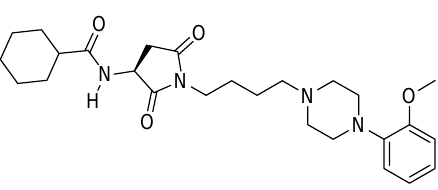
Figure 2. Chemical structure of